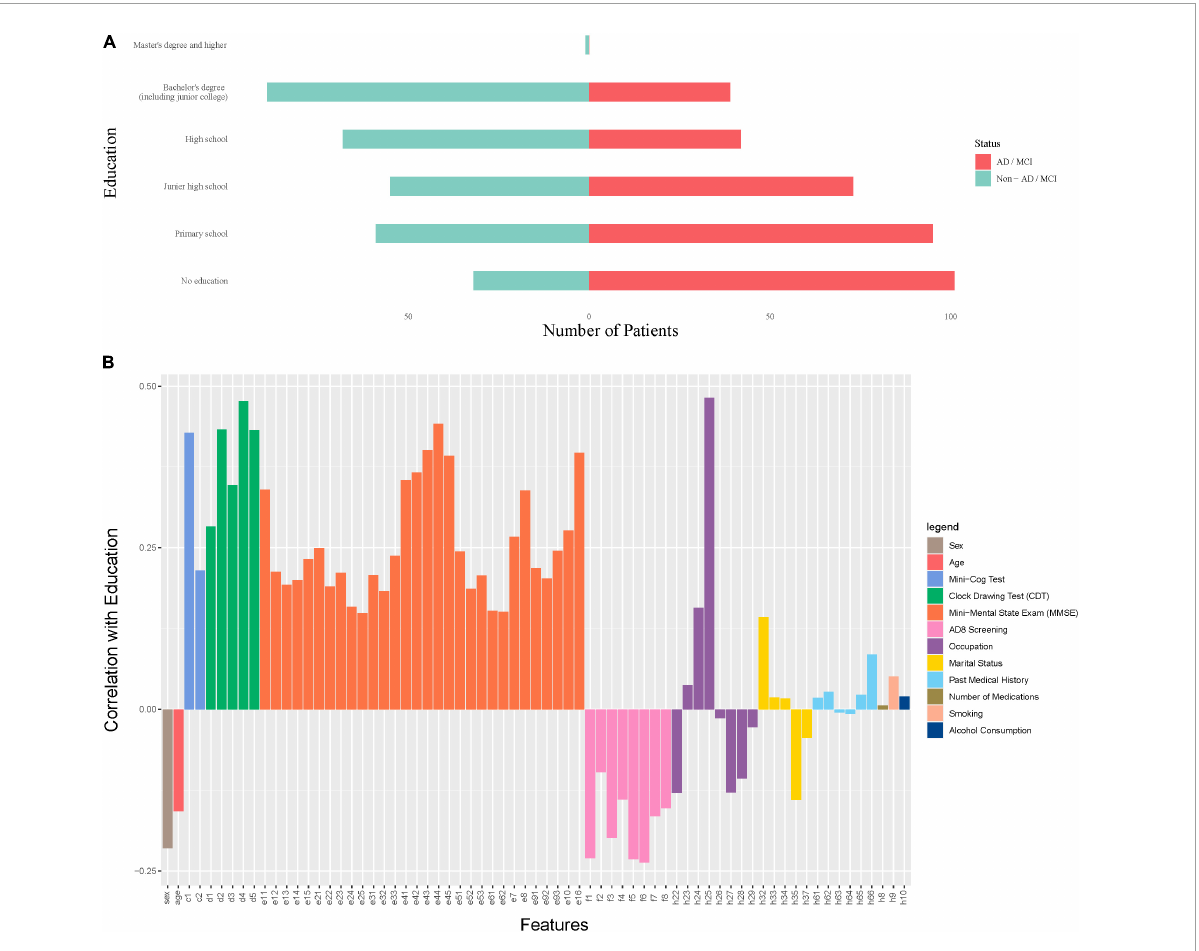
FIGURE6 The role of education in predicting dementia. (A) The marginal distribution of the levels of education on the nursing dataset. (B) The correlation coefficients between education and other features on the nursing